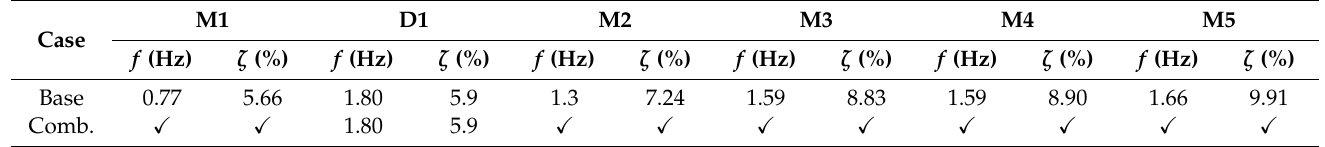
Table 17. Electromechanical comparison between the base case and the combined contribution of RESs frequency support and PSS tuning to the small signal stability for the High Import DP. Check marks indicate those modes with a damping factor greater than 10%.